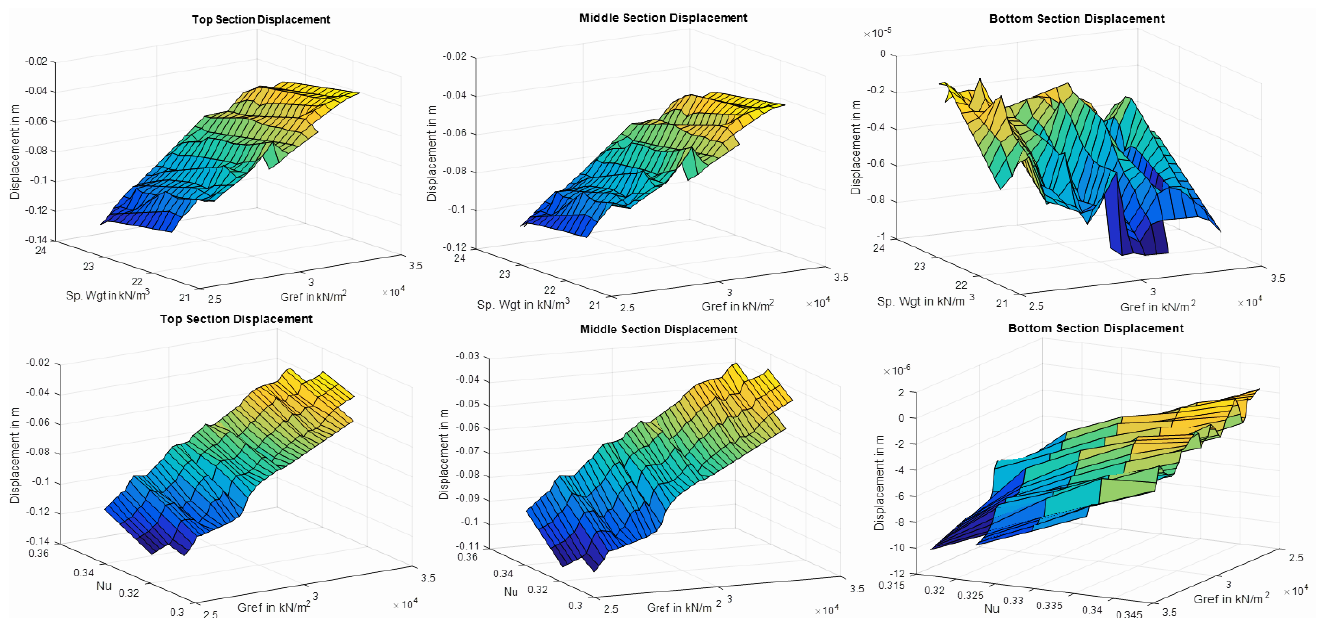
Figure 9. Displacements at different sections of the dam along INV01. Specific weight, shear modulus, and Poisson coefficient were considered to plot the results. Surface plot representation at different elevations here provide an insight into the nature of the optimization problem at hand.